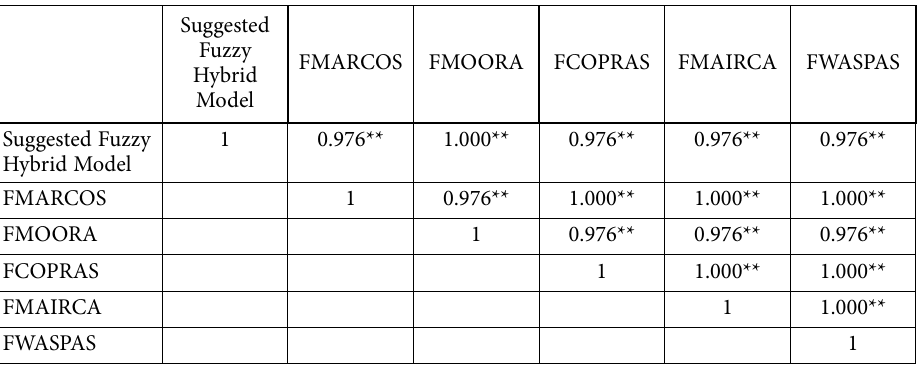
Table 15. Spearman’s correlations (SSC) Suggested Fuzzy Hybrid Model